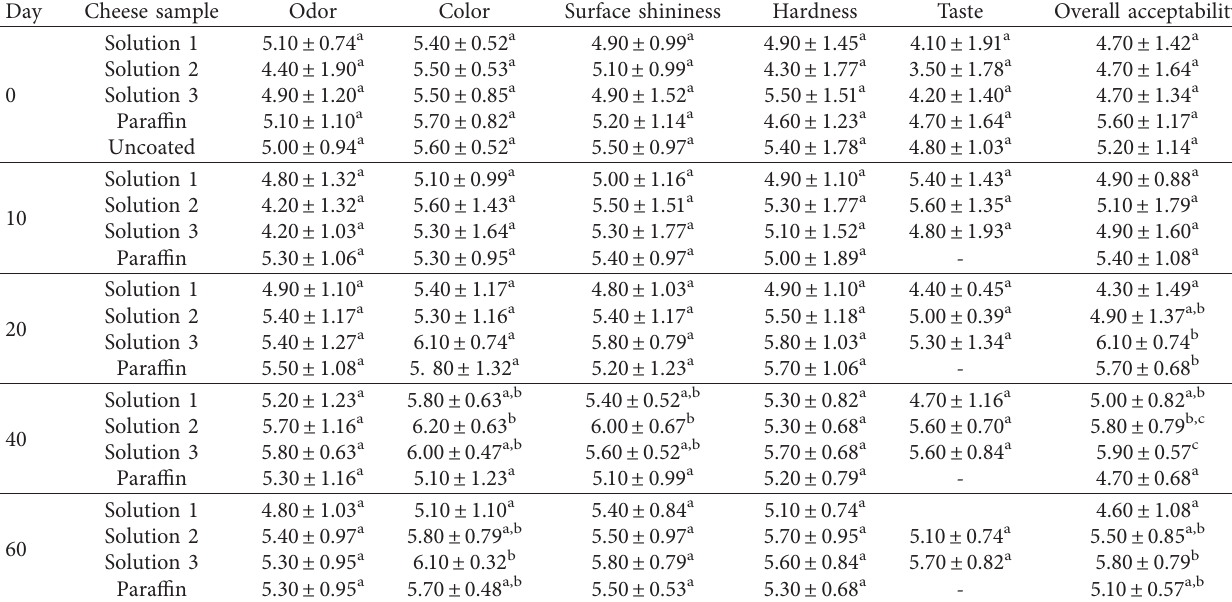
Figure 16: Mold count (means ± SD) of cheese coated with antimicrobial edible coatings compared with cheese coated with commercial coating and uncoated cheese throughout 60d of storage at 10 ° C and 85% relative humidity. Table 1: Sensory evaluation results of cheeses throughout the